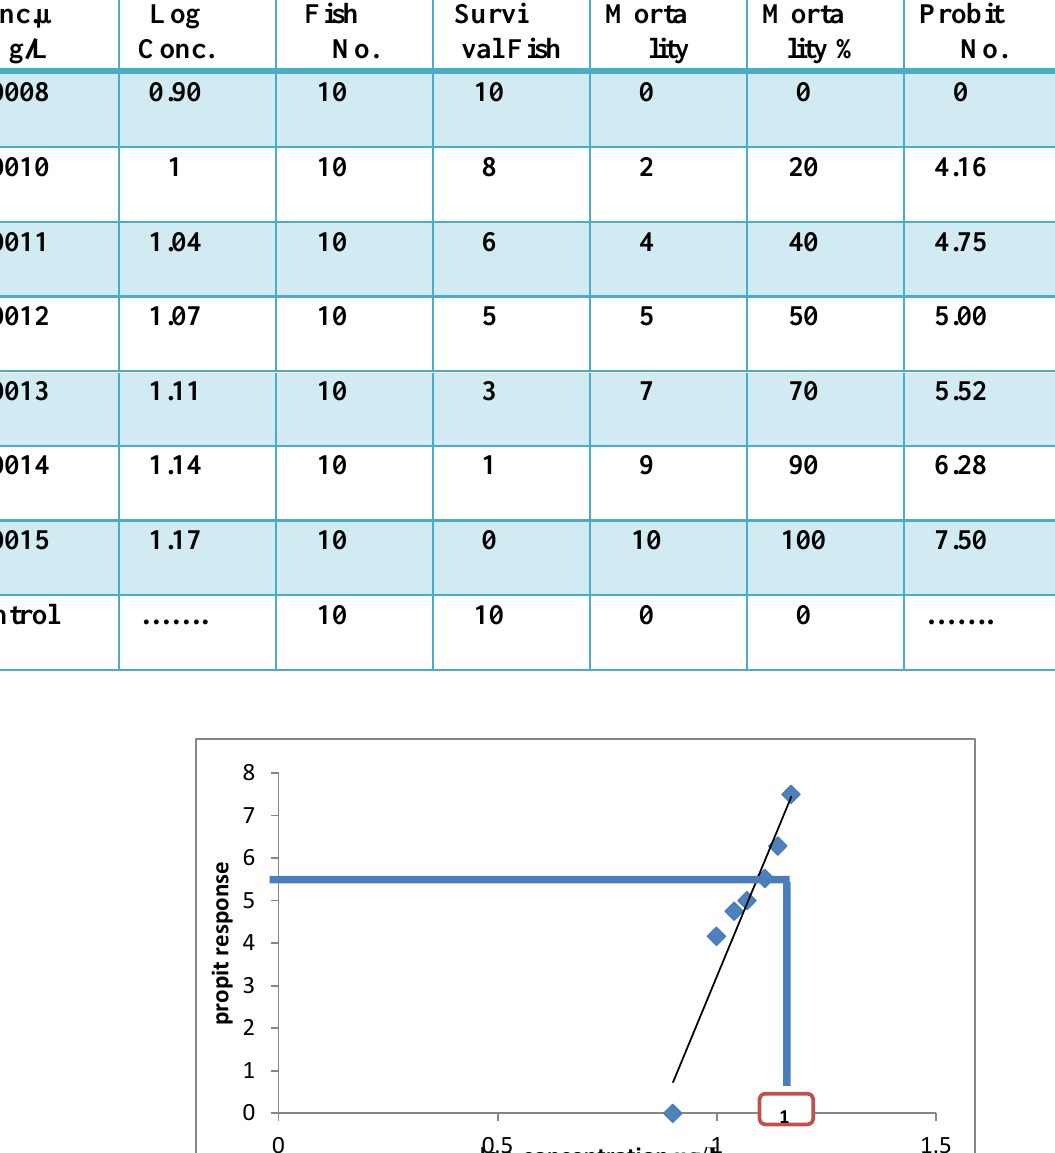
Table 1: Show LC of endosulfan on Cyprinus carpio by Probit method 50 Conc.µ